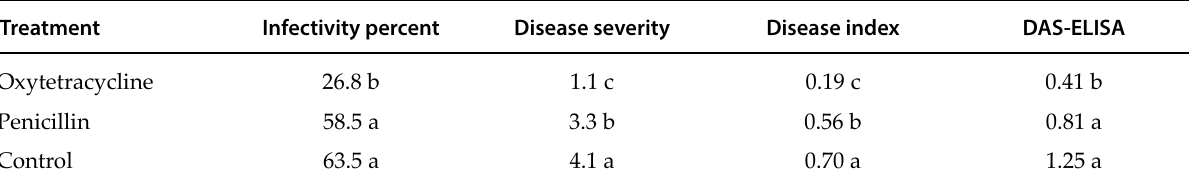
Table 2. Mean leaf infectivity percent, disease severity, disease index and amount of Xylella fastidiosa bacteria (based on absorbance at 630 nm in DAS-ELISA) on almond trees with natural infections to the pathogen treated with